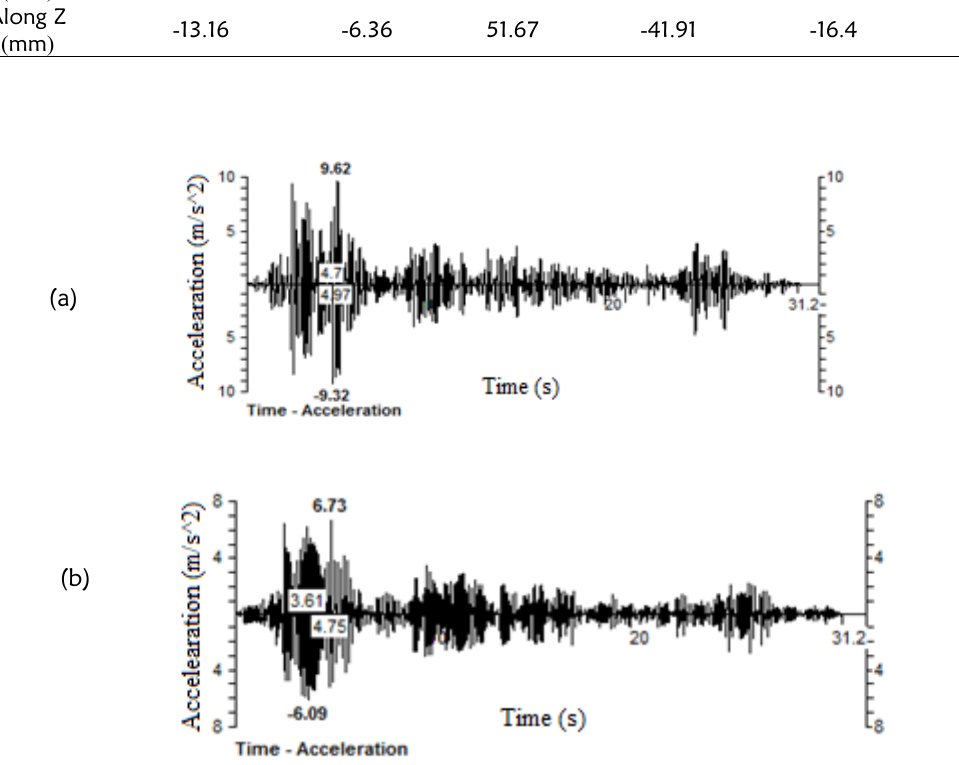
Figure 10: Time-dependent peak-to-peak acceleration along x - direction for single story ( a ) unreinforced (18 . 94 m / s 2 ) and (b ) reinforced (12 . 82 m / s 2 )